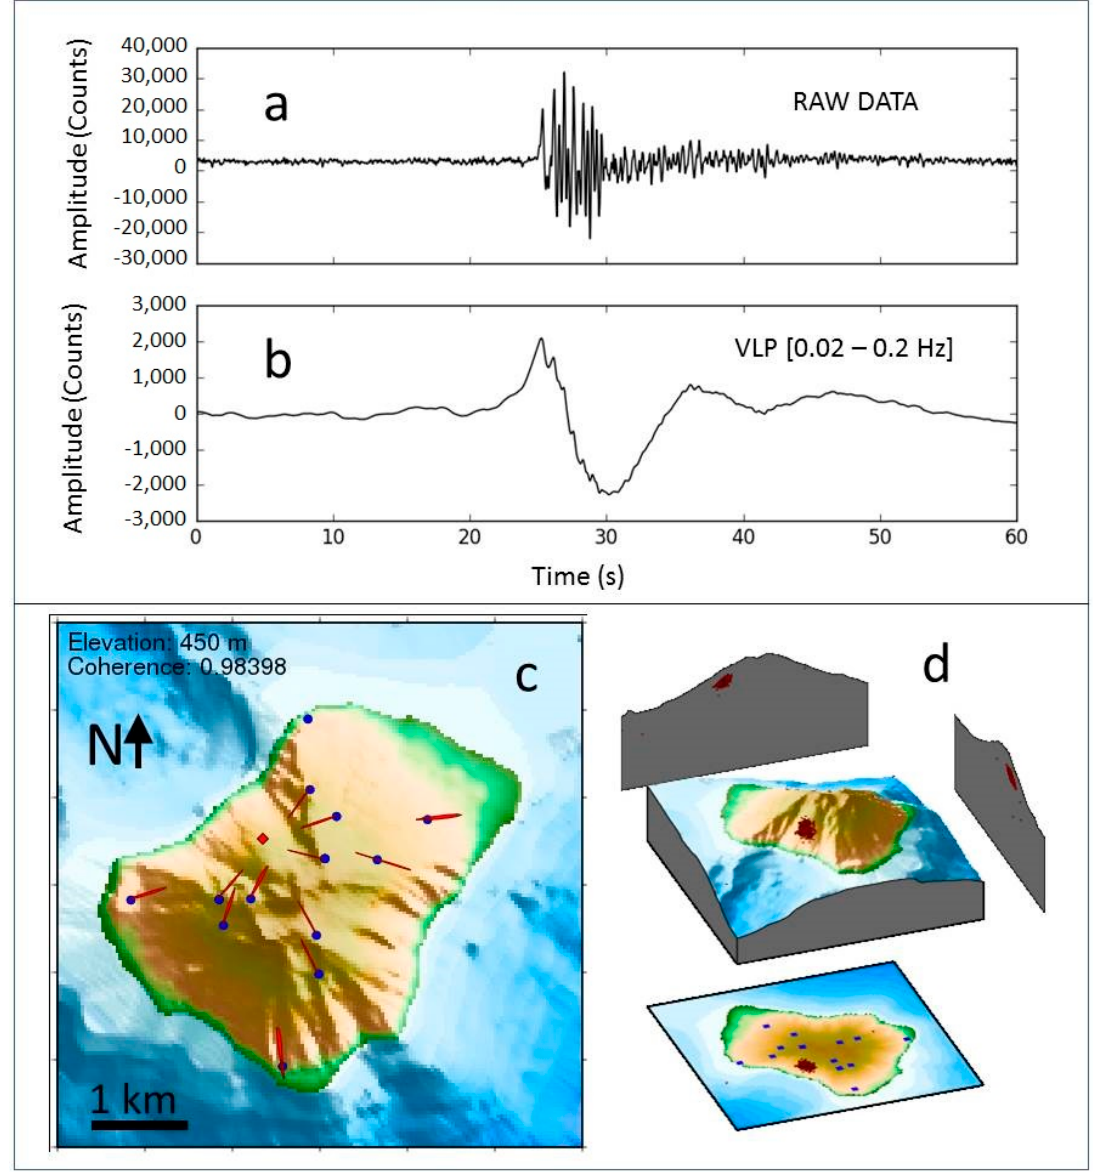
Figure 2. ( a ) Example of an explosion-quake recorded by STRA station (vertical component); ( b ) the same signal filtered in the VLP frequency band (0.02–0.2 Hz); ( c ) rose diagrams of the polarization direction of about 83,000 VLP events recorded in 2012, plotted on the map. The red diamond indicates the average source centroid, obtained from the polarization parameters, located 450m above sea level; the blue dots are the seismic stations. ( d ) The automatic locations of a subset of the VLP events recorded in 2012 carried out by the EOLO system (http://eolo.ov.ingv.it/eolo/). The subset consists of 1915 VLP events (in red) recorded by at least six stations (blue dots) with well-located hypocenters. The mean elevation of the VLP sources is about 400 m above sea level. The VLP sources retrieved by [23] are within the cloud of the VLP locations (in red).